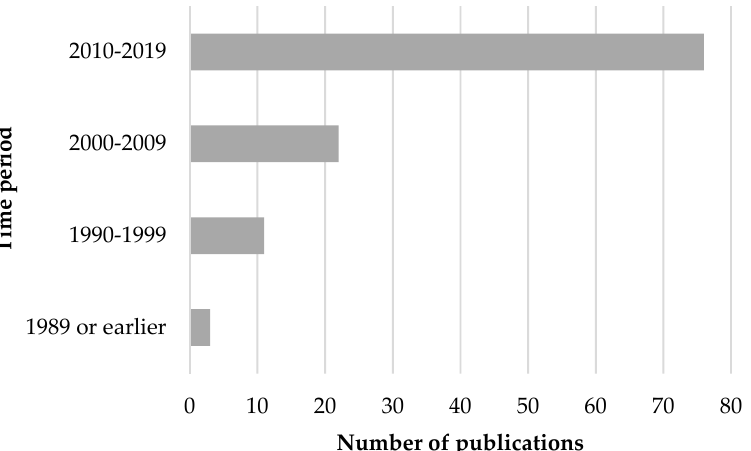
Figure 1. Evolution of worldwide studies (in Chinese, English, and Spanish) focusing on irrigation-induced landslides, by decade (not including investigations published in 2020). Table 1. Documented cases of irrigation-induced landslides within the Chinese (*), English (**), and Spanish (***) literature.